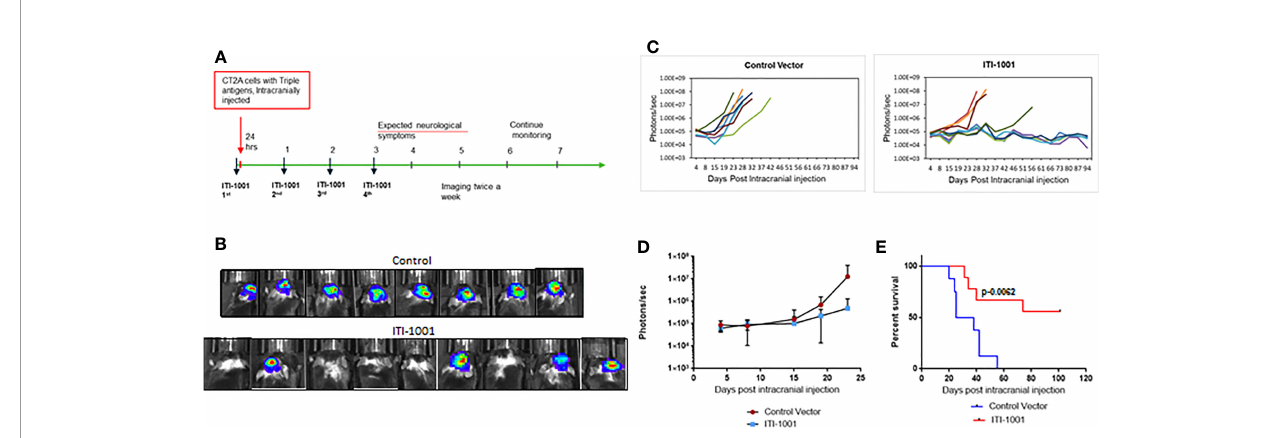
FIGURE 2 | ITI-1001 confers survival bene fi t in an orthotopic syngeneic GBM mouse model. (A) Schedule for ef fi cacy study with intracranial injection, vaccinations, and imaging information. (B) Representative bioluminescence images of mice injected with CT2A cells expressing the three human cytomegalo virus antigens in control and ITI-1001-treated group and the maximum signal shown by each mouse. (C) Tumor growth kinetics plotted using bioluminescence signal and the days post intracranial injection for control and ITI-1001 group. (D) Average bioluminescence is shown in the third plot for the time points where all the mice were alive. (E) Survival curve for control and ITI-1001-treated group plotted with percent survival and days post intracranial injection. Control group (n = 8) had a median survival of 31.5 days, and ITI-1001 (n = 9) median survival could not be calculated due to insuf fi cient deaths. p value (0.0062) from log-rank (Mantel – Cox) test denotes the statistical difference between the two curves. The percent survival was 56%.